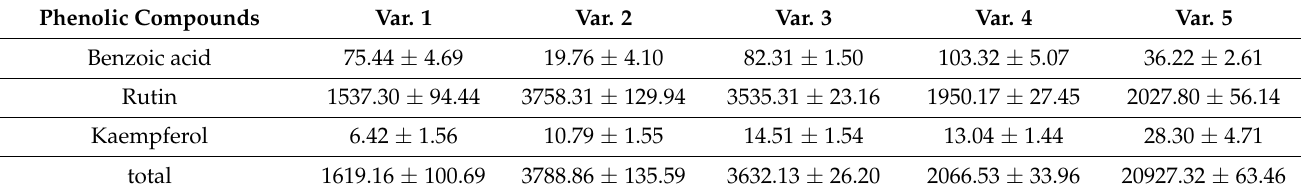
Table 3. Range of values derived through HPLC analysis for moringa